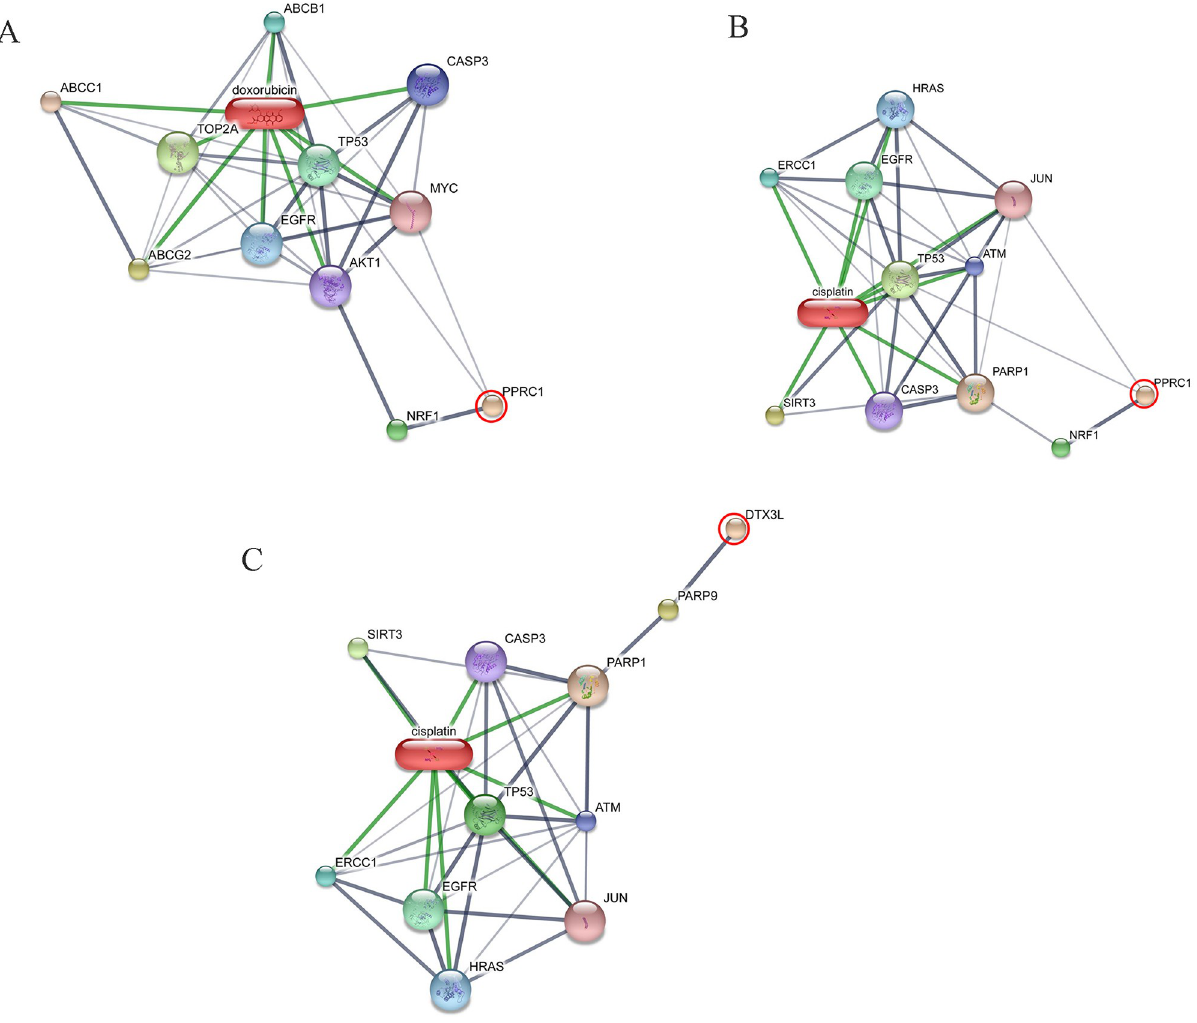
Fig 6. Involvement of peroxisome proliferator-activated receptor gamma, coactivator-related 1 (PPRC1) and deltex 3-like (DTX3L) in networks of protein–chemotherapy drug interactions, cisplatin and doxorubicin. Interactions of PPRC1 with doxorubicin (A) , PPRC1 with cisplatin (B) and DTX3L with cisplatin (C) are shown. Red circles: PPRC1 and DTX3L. Abbreviations: ABCB1, ATP-binding cassette, sub-family B, member 1; ABCC1, ATP-binding cassette, sub-family C, member 1; ABCG2, ATP-binding cassette, sub-family G, member 2; AKT1, v-akt murine thymoma viral oncogene homolog 1; ATM, ataxia telangiectasia mutated; CASP3, caspase 3; EGFR, epidermal growth factor receptor; ERCC1, excision repair cross- complementing rodent repair deficiency, complementation group 1; HRAS, v-Ha-ras Harvey rat sarcoma viral oncogene homolog; JUN, jun proto- oncogene; MYC, v-myc myelocytomatosis viral oncogene homolog; nuclear respiratory factor 1 (NRF1), PARP1, poly (ADP-ribose) polymerase 1; PARP9, poly (ADP-ribose) polymerase family, member 9; SIRT3, sirtuin 3; TOP2A, topoisomerase II alpha; TP53, tumor protein p53.